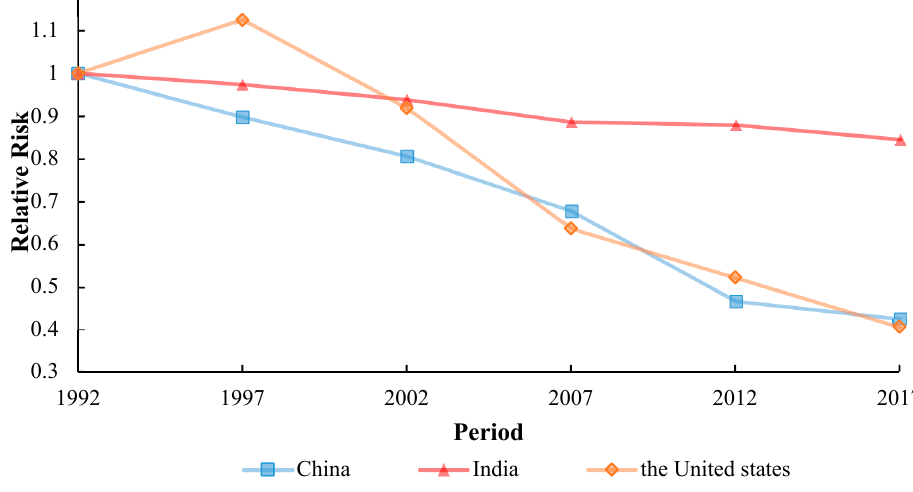
Figure 7. Period effects on TB incidence rate for China, India, United States, from 1992 to 2017.